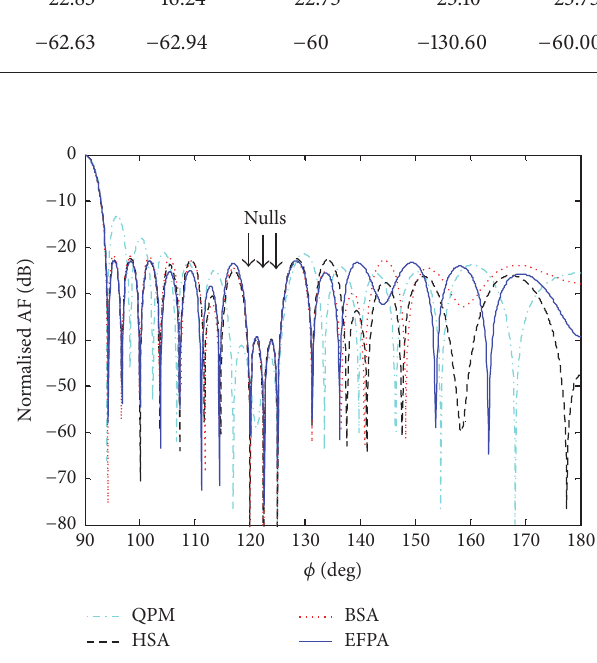
Figure 7: Radiation plot of 28-element EFPA optimized